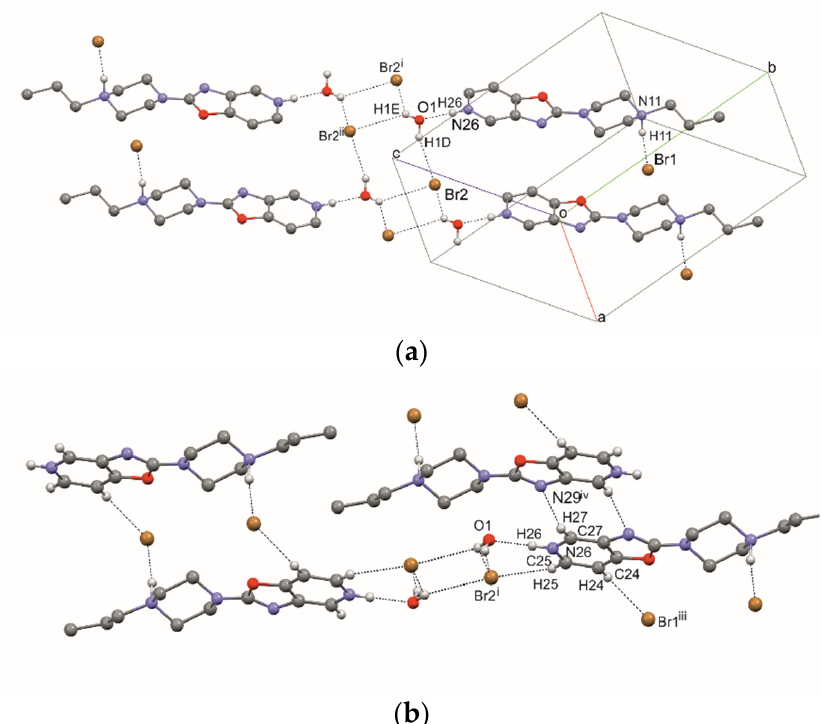
Figure 6. The intermolecular hydrogen bonds in compound 1 . ( a ) Strong hydrogen bonds, ( b ) all hydrogen bonds. [Symmetry code: (i) x − 1, y, z; (ii) − x, − y, − z+2; (iii) − x, − y+1, − z+1; (iv) − x+1, − y+1, − z+2.]. Table 2. Strong hydrogen-bond geometry (Å, º) for 1. Symmetry codes: (i) x − 1, y , z